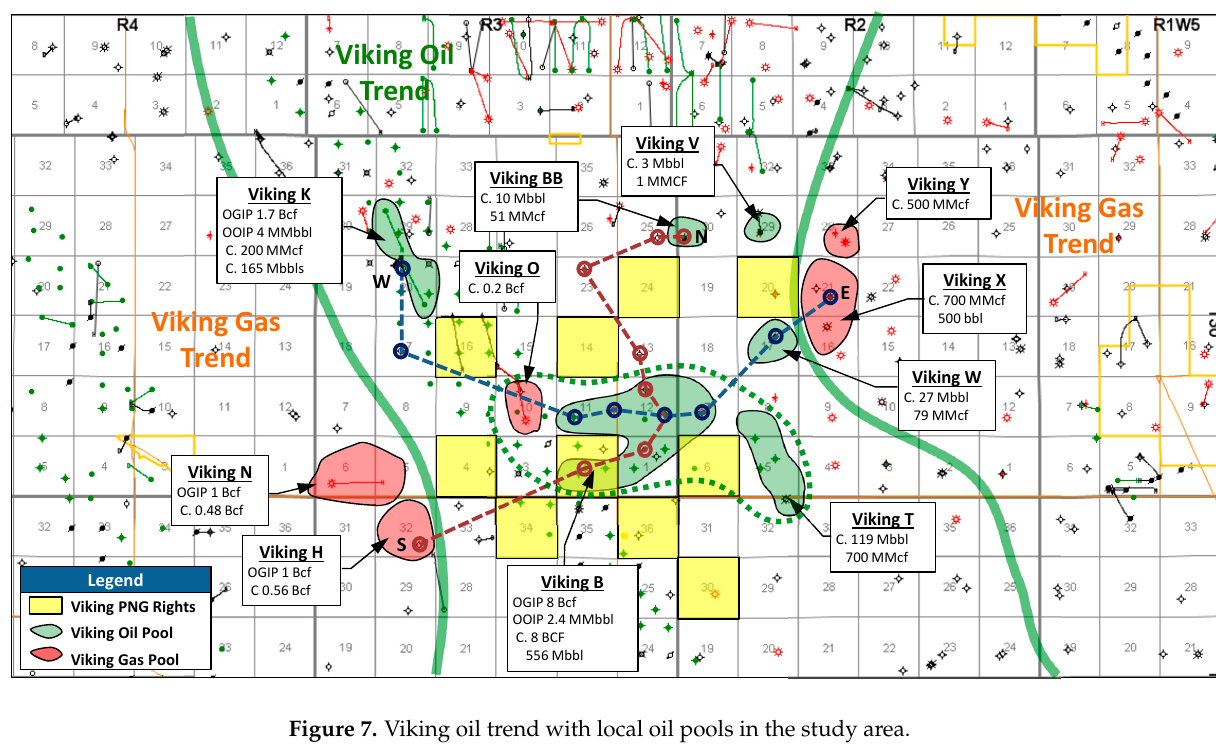
Figure 7. Viking oil trend with local oil pools in the study area.